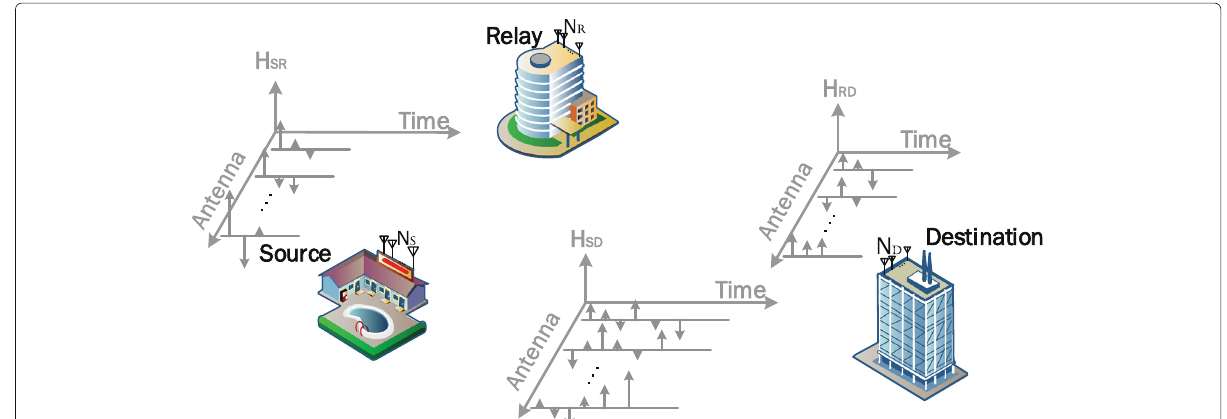
Fig. 1 Conceptual system model for MIMO-OFDM relay network and joint